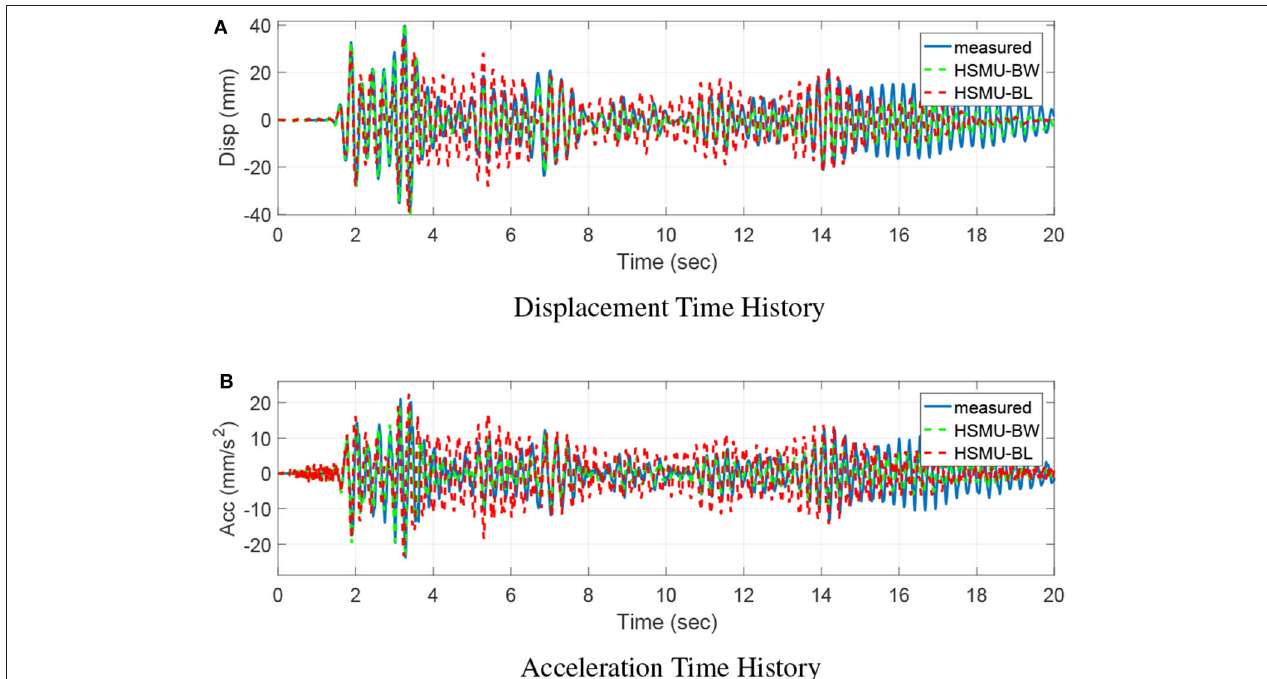
FIGURE 7 | S1: Top floor time history responses. (A) Displacement time history, (B) Acceleration time history.